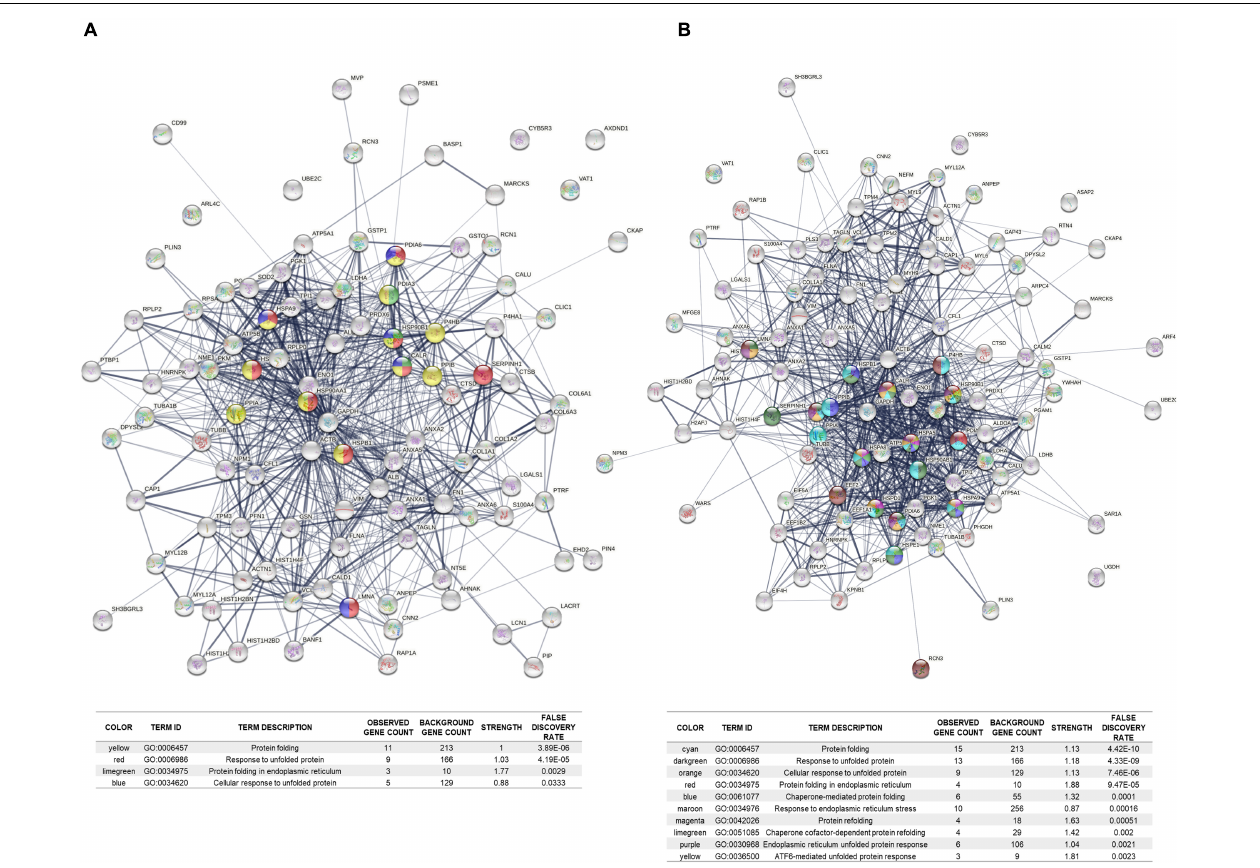
FIGURE 8 | Cluster of stress response proteins (HSP) identified in the protein extracts of fibroblasts from the FAD patients (AD1 and AD2) with the mutation M146L. The proteins identified in the mass spectrometry of FAD fibroblasts (AD1 and AD2) and control fibroblasts (NA2 and NA3) were analyzed in the STRING database platform and interactomes based on functional and physical associations were generated. (A) Protein interactome for the fibroblasts of the control patients. (B) Protein interactome for the fibroblasts of the FAD patients (AD1 and AD2) identifying the presence of HSPs. For each interactome, the number of biological processes associated with protein folding mediated by chaperones is reported in the lower panel of this figure, both for the control group (A) and for the FAD group (B) . Pointing out the strength of the enrichment as a measure of what is observed and what is expected, and the value of the false discovery rate as a measure of the significance of the enrichment. The thickness of the lines between the proteins indicates the strength of the association.